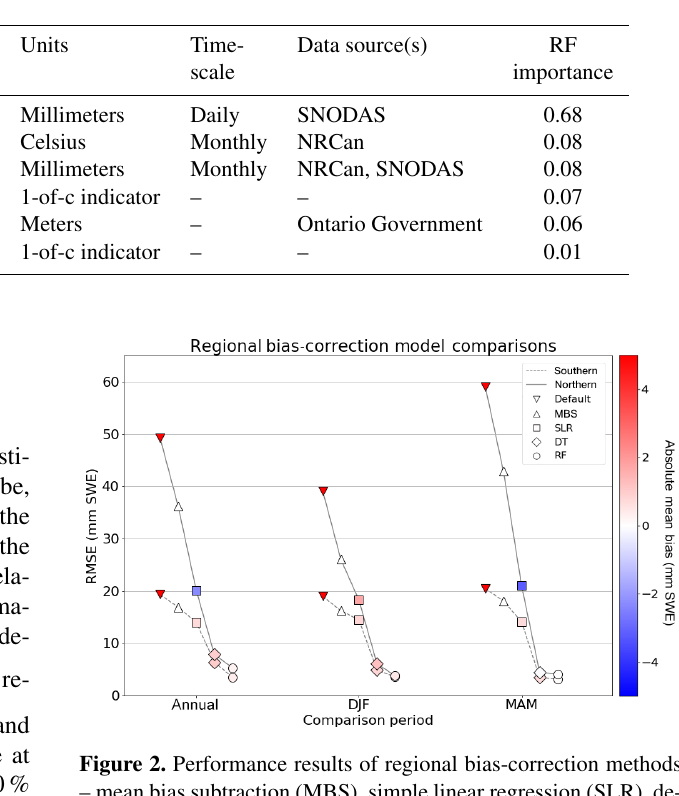
Table 2. Predictor names and details used in the decision tree, multiple linear regression and random forest bias-correction models. Also included are their respective variable units, measurement timescales, data sources and variable importance scores produced by the random forest model.